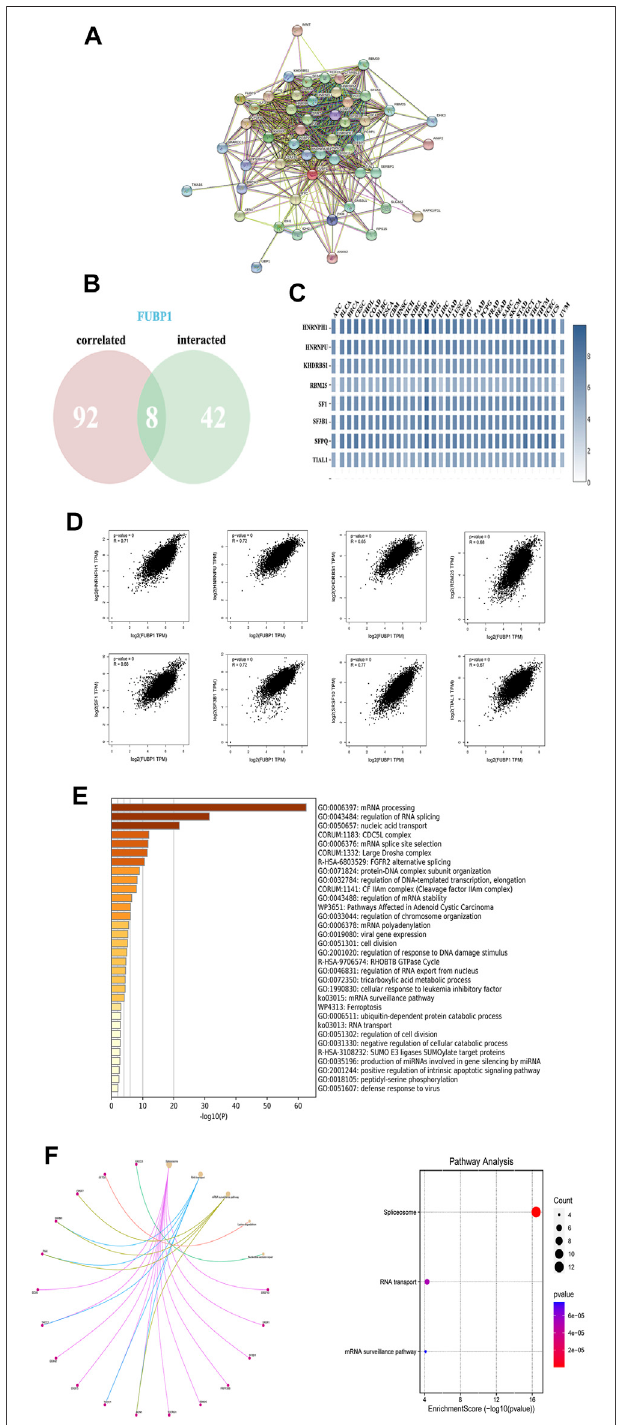
FIGURE 8 | The enrichment of FUBP1-related genes and pathways. (A) ThePPInetworkwasconstructedusingtheSTRINGdatabase,andthetop50 proteinsaredisplayed. (B) Anintersectionofeightproteinswasobtainedfrom the 100 FUBP1-correlated proteins via GEPIA2 and 50 FUBP1-binding proteins via STRING. (C) The expression of the eight genes in each cancer type is displayed in a heatmap. (D) The potential correlation between FUBP1 ( Continued )